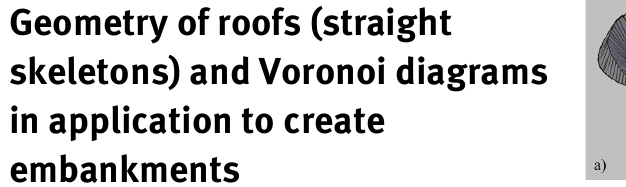
Figure 3: The roof model: a) embankment over closed broken line with greater accuracy; b) the model of the embankment of a given height (Koźniewski et al., 2013)